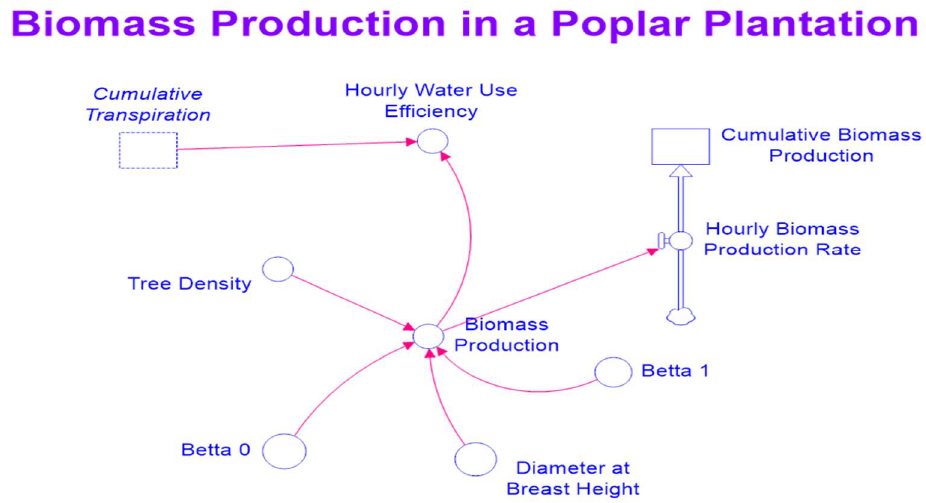
Figure 3. A map of the STELLA model for simulating biomass production.